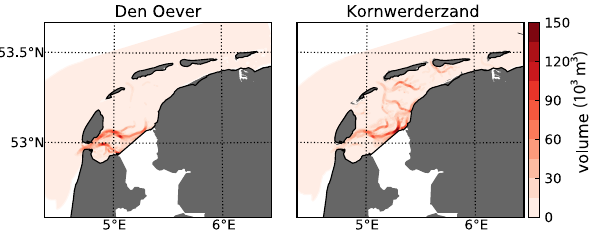
Figure 17. Average volume (10 3 m 3 ) per horizontal grid cell of the fresh water from (a) Den Oever and (b) Kornwerderzand for the month of April